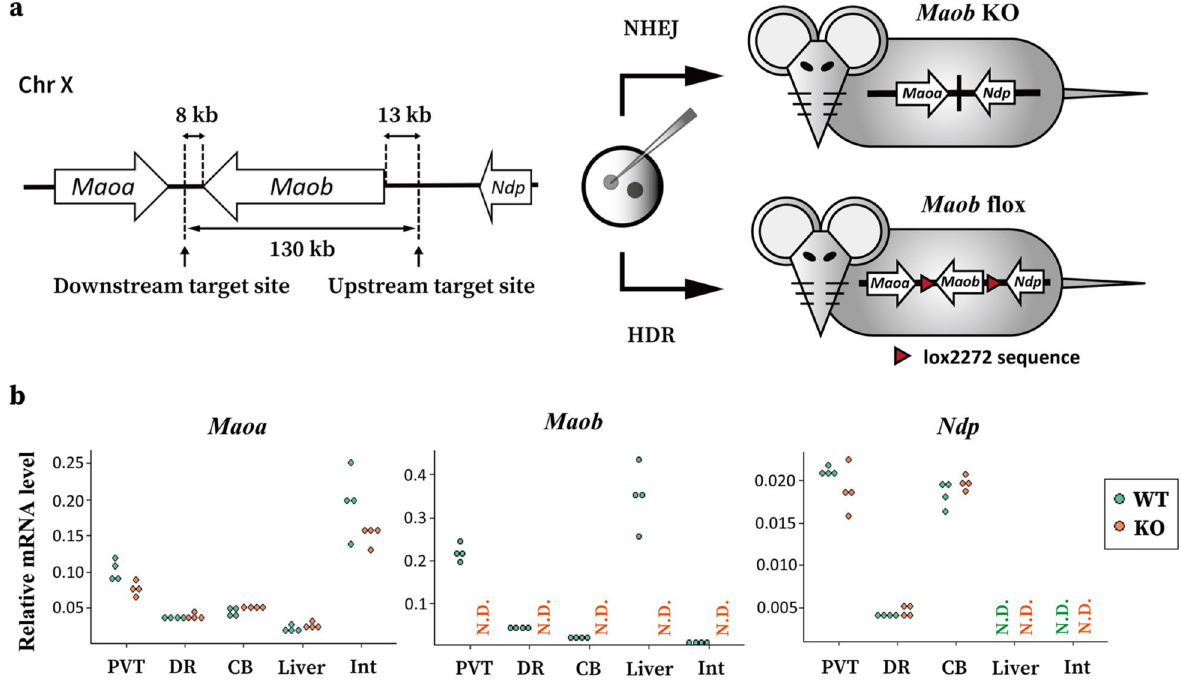
Figure 2. Generation of Maob KO mice and Maob flox mice. ( a ) A strategy for simultaneous generation of Maob KO and Maob flox alleles using the CRISPR/Cas9 system. The two gRNA were designed to target the flanking regions of the Maob gene located on the X chromosome (Chr X) and ~ 13-kb upstream of the start codon and ~ 8-kb downstream of the stop codon. A CRISPR/Cas9 cocktail containing two single-stranded DNA donor templates with the lox2272 was microinjected into mouse eggs. Non-homologous end-joining (NHEJ) resulted in the deletion of ~ 130 kb (KO allele) or homology-directed repair (HDR) generated the floxed allele (flox). ( b ) Reverse transcription-quantitative PCR analysis of expression of Maoa , Maob , and Ndp in the PVT, the dorsal raphe (DR), cerebellum (CB), liver, and intestine (Int) of wild-type (WT, Maob (+/Y)) and Maob KO (KO, Maob (−/Y)) mice ( n = 4 for each group). Maob expression was not detected in any tissues of Maob KO mice. N.D., not detected. mRNA levels of Maoa or Ndp did not differ significantly between genotypes (Student’s t- test with Bonferroni